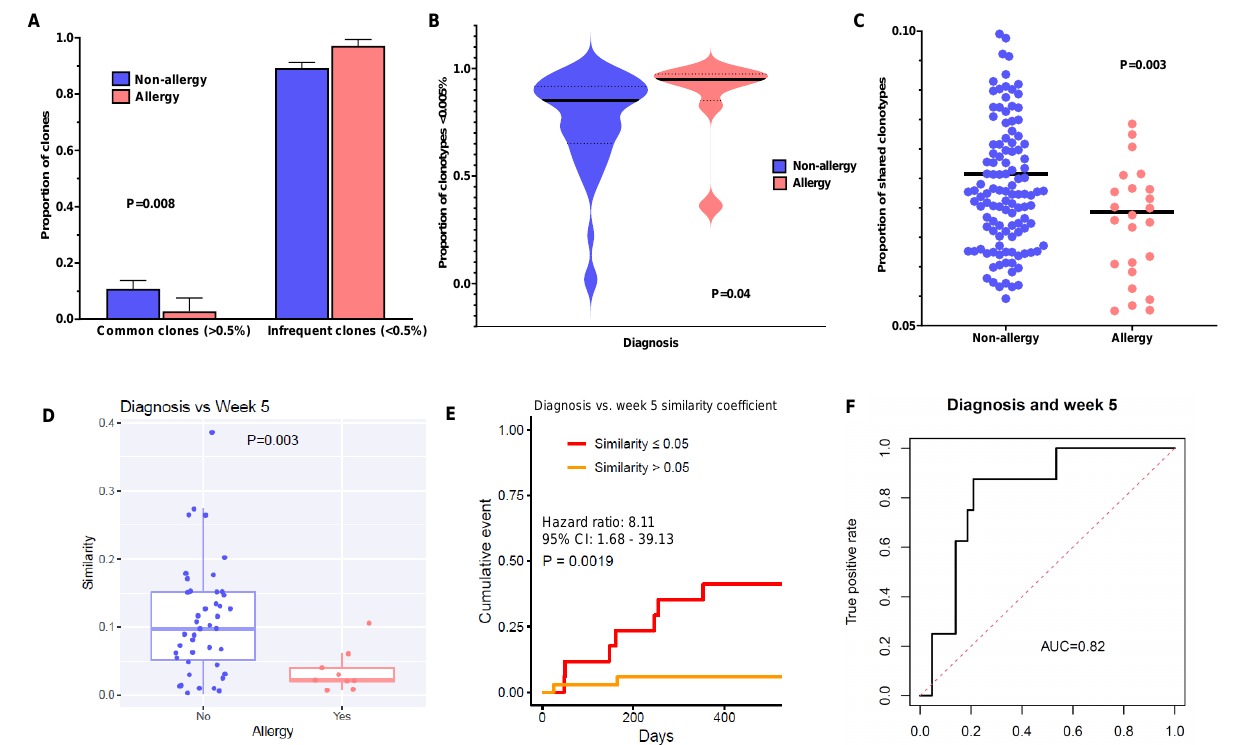
Figure 2. TCR-B diversity in allergic patients is characterized by a higher frequency of infrequently occurring clonotypes, which are less shared amongst patients and display more longitudinal vari- ability: ( A ) Proportion of common ( ≥ 0.5%) and infrequent (<0.5%) clones in non-allergy vs. allergy groups. The proportions of common ( ≥ 0.5%) and infrequent clones (<0.5%) are shown in the bar chart. Non-allergy is shown in blue, and allergy is shown in red. Allergic patients have a signifi- cantly higher proportion of infrequent clones and a lower proportion of common clones. p -Values determined by the chi-squared test. ( B ) Proportion of rare clones (<0.005%) in non-allergy vs. allergy groups at diagnosis. The proportions of rare clones are plotted in the violin plots for the non-allergy vs. allergy groups. Non-allergy is shown in blue, and allergy is shown in red. The median in each group is noted as a bold horizontal black line. p -Values determined by the Mann–Whitney